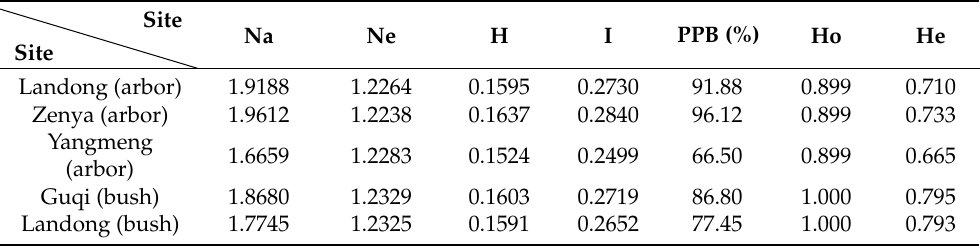
Table 4. Genetic diversity parameter analysis for five populations of ancient tea plant germplasm using 15 SSR markers.